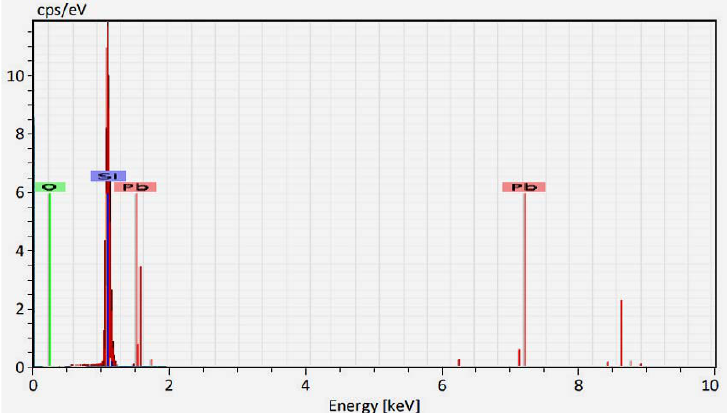
Fig.4: EDX spectrum analysis of lead